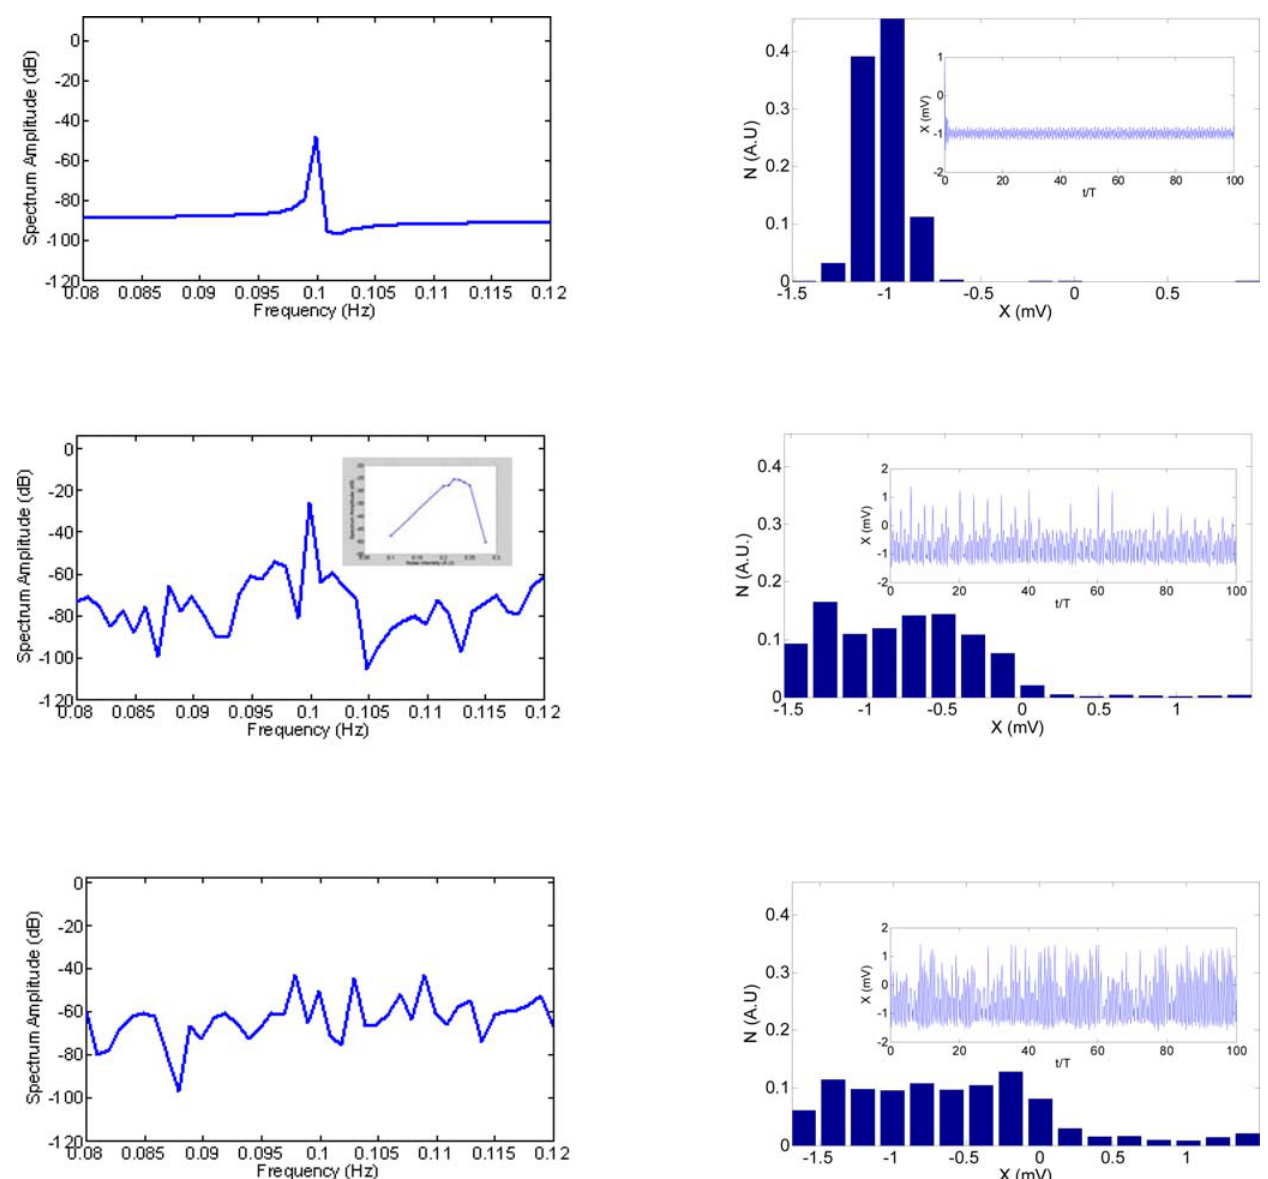
Figure 6. Theoretical model results for unimodal SR. (Left column) shows the neurons’ spectrum amplitude as a function of the noise intensity s 2 . The insert (left column, middle row) shows the well-known SR inverted u-shape function. The maximum peak is found when P =10 dB . Right column shows neuronal firing histograms with their corresponding time histories. T is the signal period and N means the probability to have certain neuronal activity